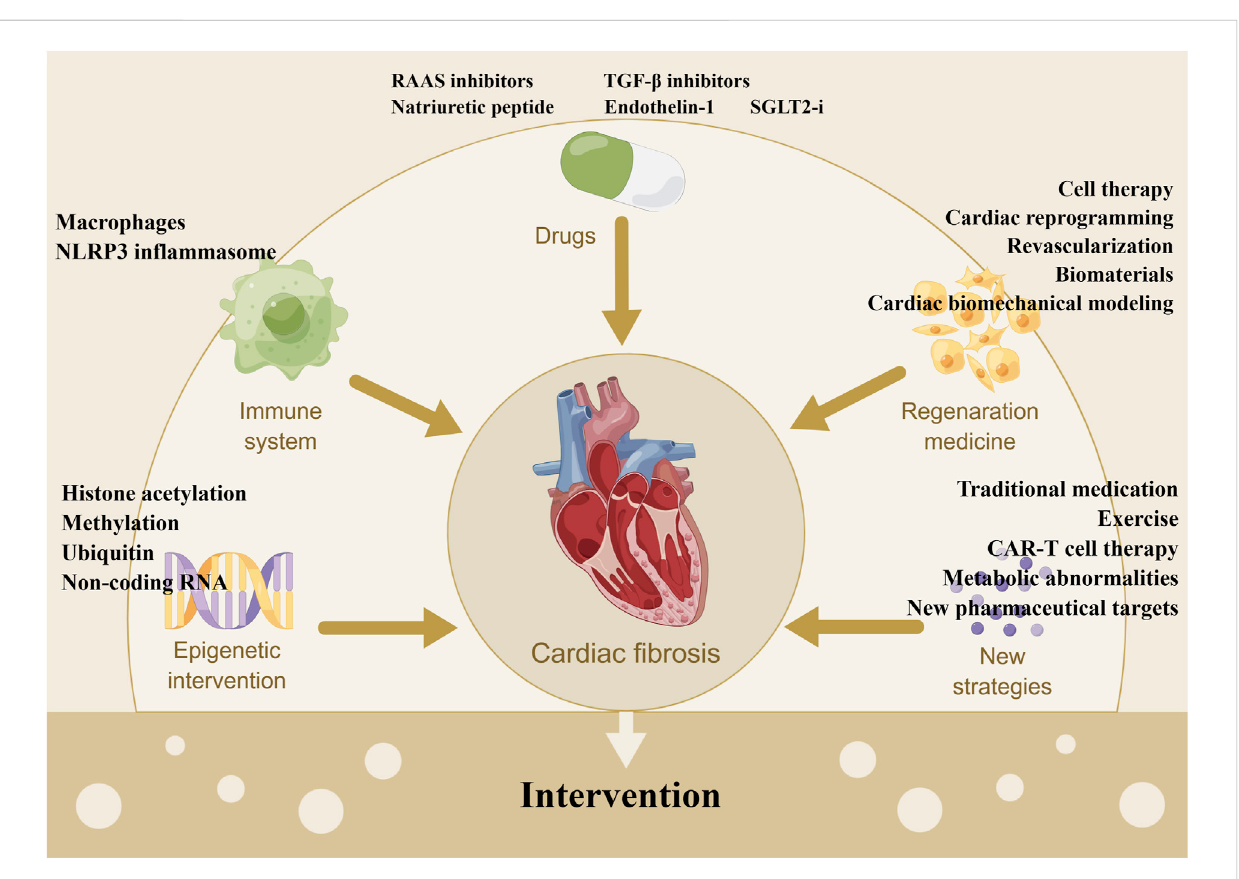
FIGURE 2 Summary of the interventions of cardiac fi brosis. Note: CAR, chimeric antigen receptor; NLRP3: nod-like receptor protein three; RAAS: renin- angiotensin-aldosterone system; SGLT2-i: sodium-glucose cotransporter-2 inhibitor; TGF- β : transforming growth factor β .